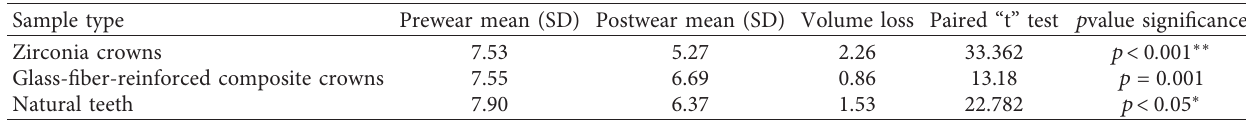
Table 2: Volume loss of the antagonistic teeth against glass-fiber-reinforced composite crowns, zirconia crowns, and natural teeth groups. Sample type